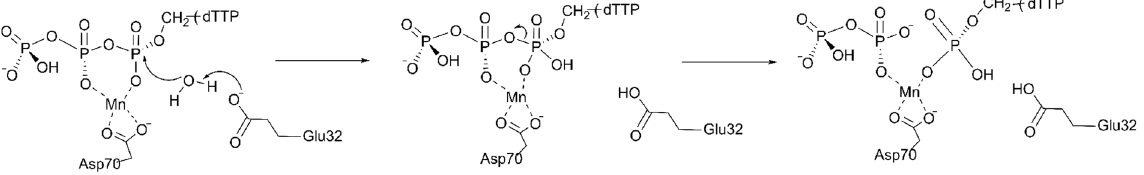
Figure 6. YhdE’s pyrophosphatase reaction scheme in a two-step associative